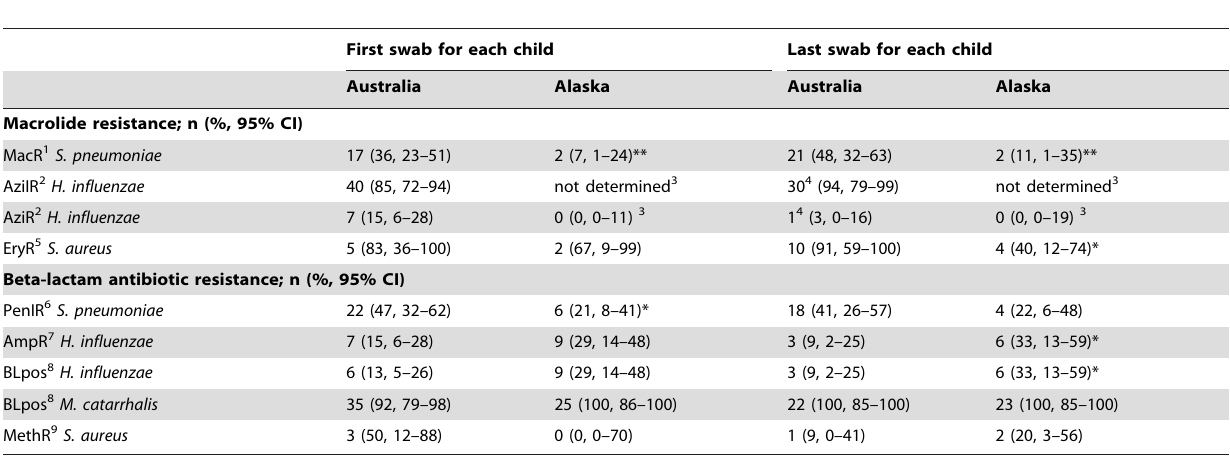
Table 3. Antibiotic resistance (proportion of carriers) in respiratory bacteria from Australian and Alaskan children at baseline and end of study.